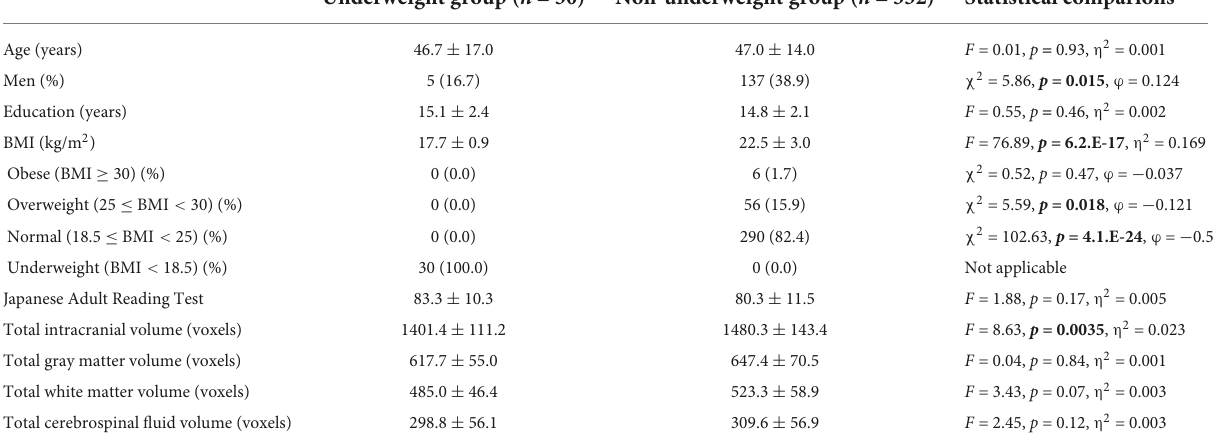
TABLE 2 Comparisons of variables between the underweight and non-underweight